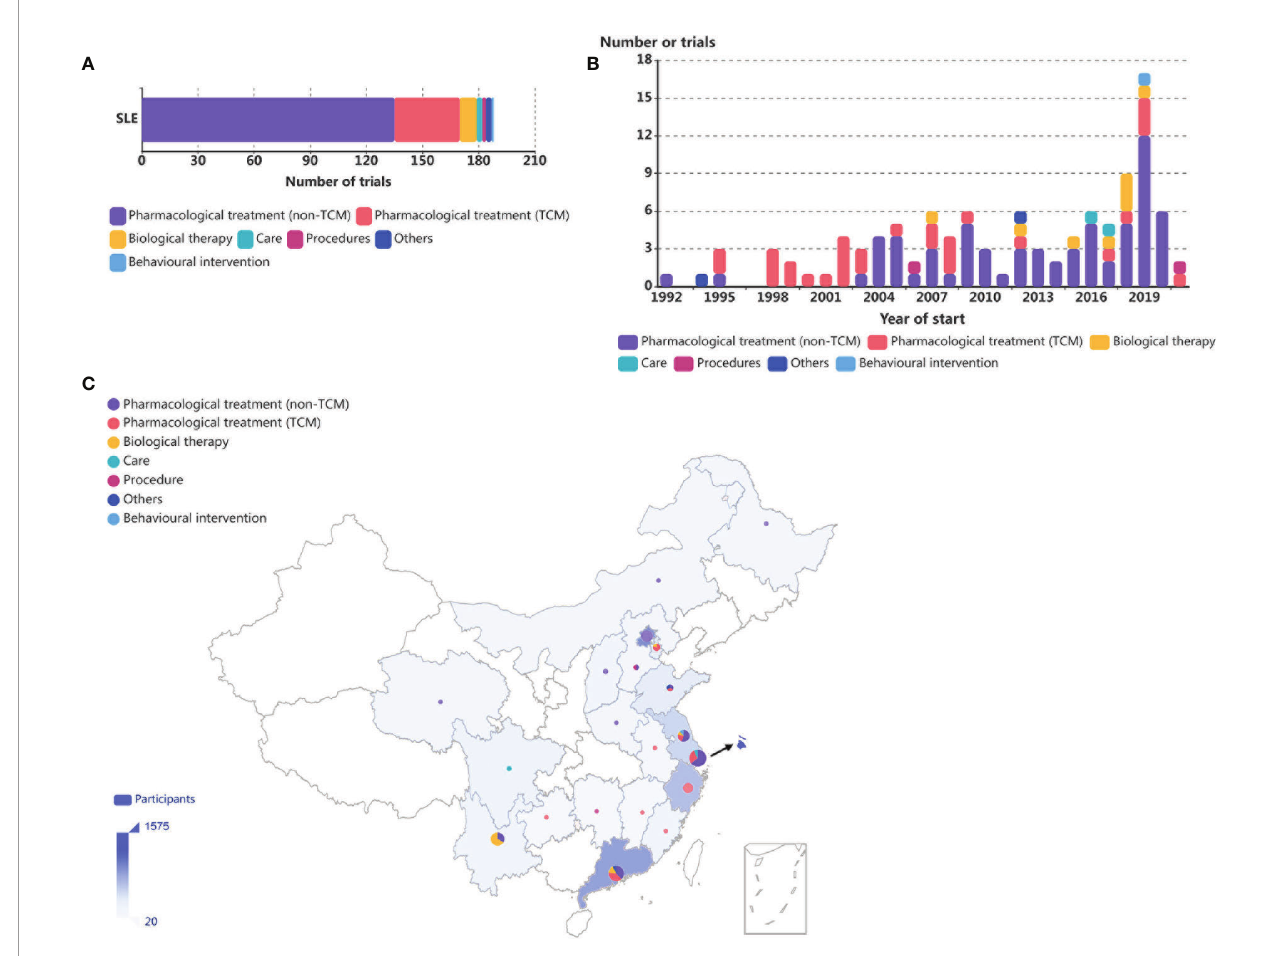
FIGURE 1 | Distribution of SLE RCTs in mainland China. (A) Number of SLE RCTs conducted in mainland China in the last three decades by intervention categories. (B) Number of RCTs on SLE conducted in mainland China, by year of initiation and intervention categories. Eleven trials were not included because of lack of information on year of initiation. (C) Geographical distribution of the af fi liations of primary investigators of RCTs by intervention categories and participants in SLE RCTs conducted in mainland China. The numbers of trials are summarized by province or municipality and are shown as pie charts, with larger charts indicating larger numbers of trials and the distribution of intervention categories represented within each geographical area. Numbers of participants are summarized by country and are represented by the shade of blue on the map, with deeper shades indicating larger numbers of